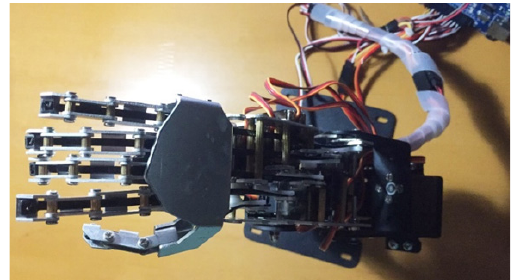
Figure 14. Manipulator in the test.